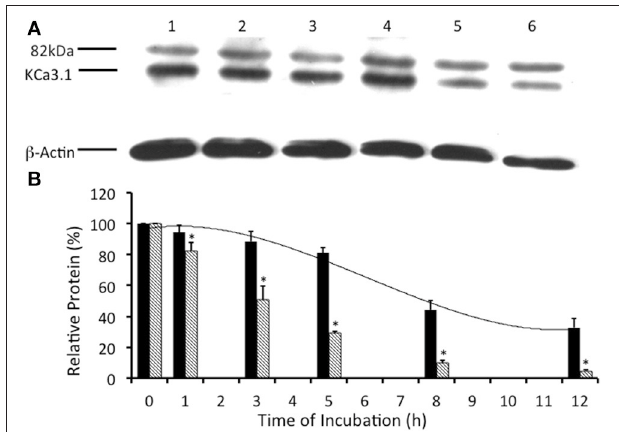
FIGURE 8 | Effect of lysosomal inhibitors on the streptavidin-labeled membrane bound KCa3.1-BLAP channels. Lysosomal activities were inhibited with leupeptin (100 µ M, s and m) and pepstatin (1 µ g/ml, s and m; L/P) to determine the effect on the degradation of KCa3.1. (A) The degradation time course was executed with the addition of leupeptin and pepstatin after streptavidin labeling of KCa3.1. After labeling, cells were further incubated in 37 ◦ C for 0 (no incubation), 1, 3, 5, 8, or 12 h with L/P before cells were lysed and detection of KCa3.1 by immunoblot. Lane 1: Control no incubation ( t =